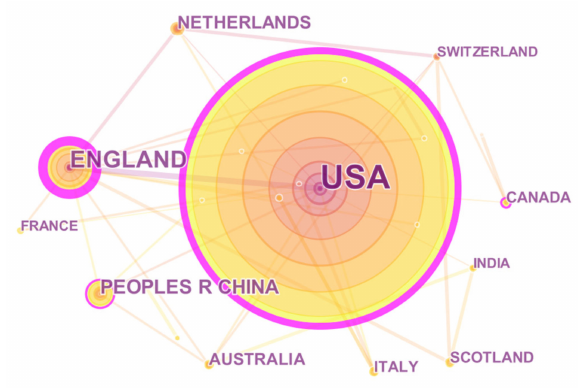
Figure 3. Network graph of countries /